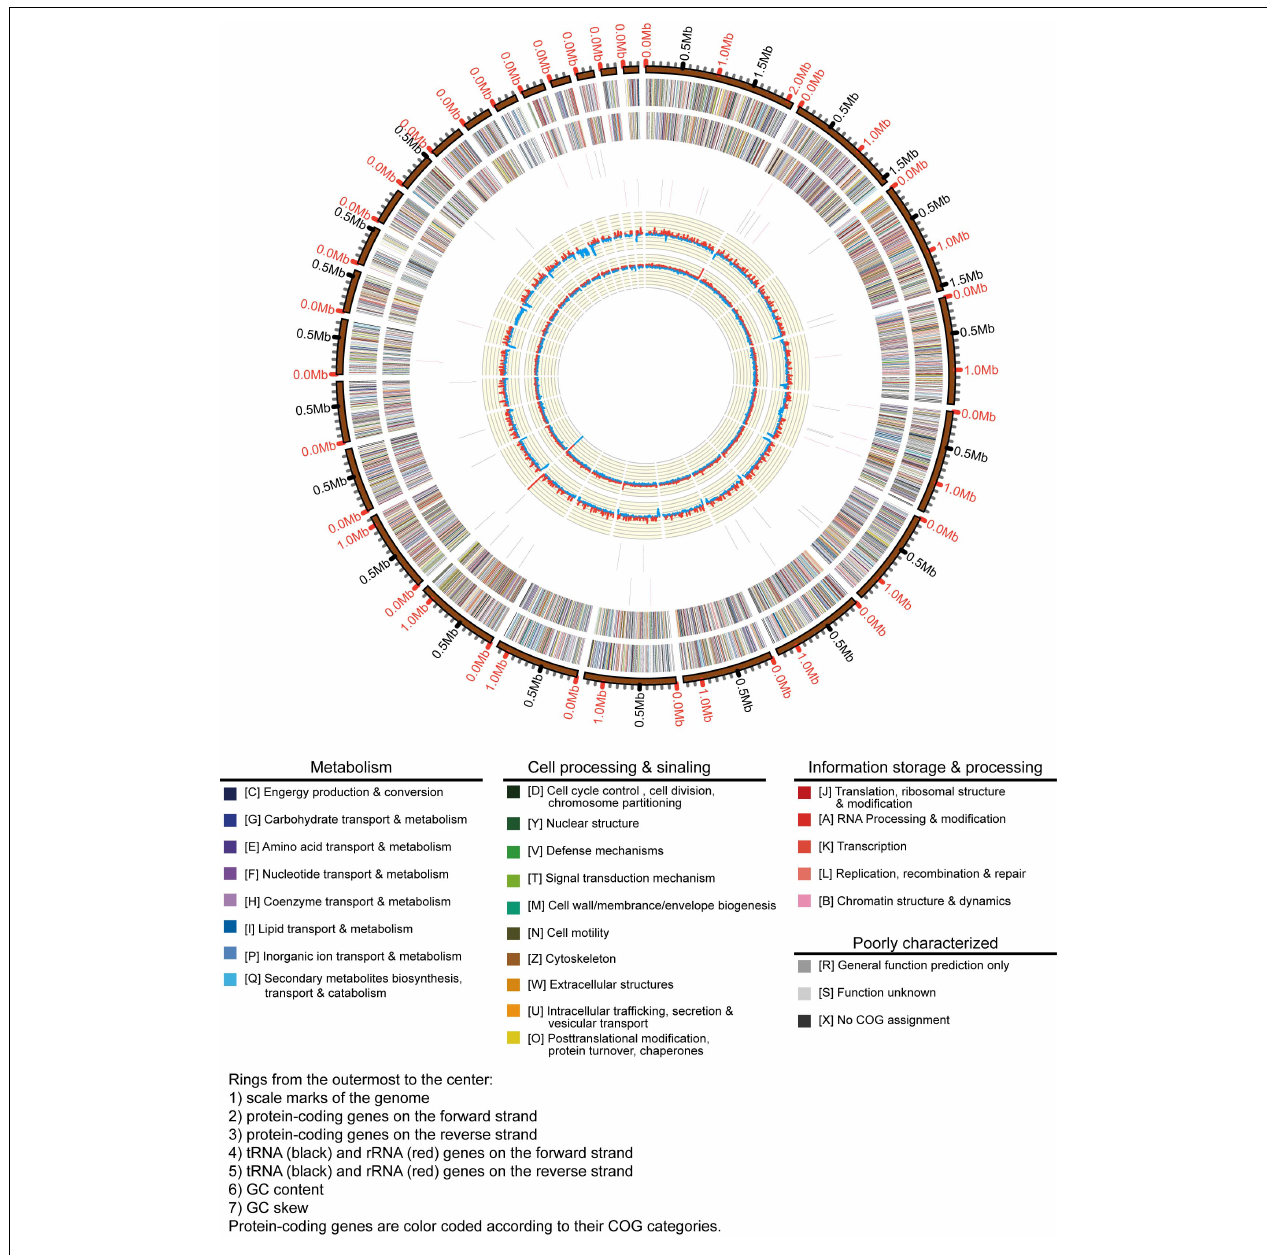
FIGURE 2 | Graphical map of the A. bohemica